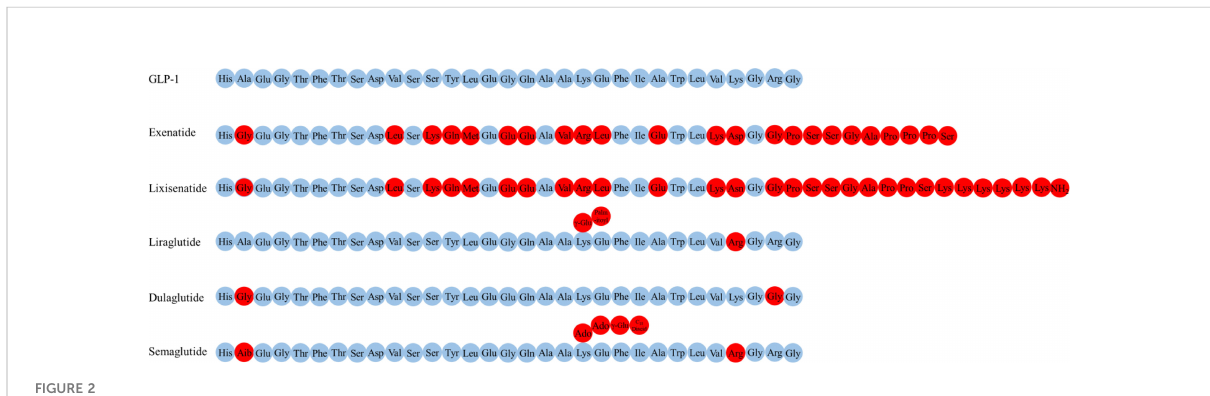
FIGURE 2 The amino acid structure of various GLP-1R